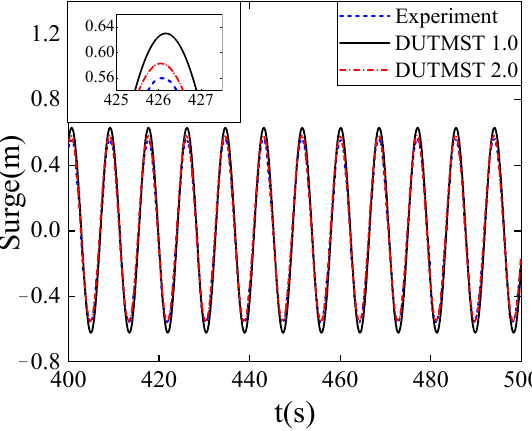
Figure 7. Surge response of the Serbuoys-TLP to wave action.